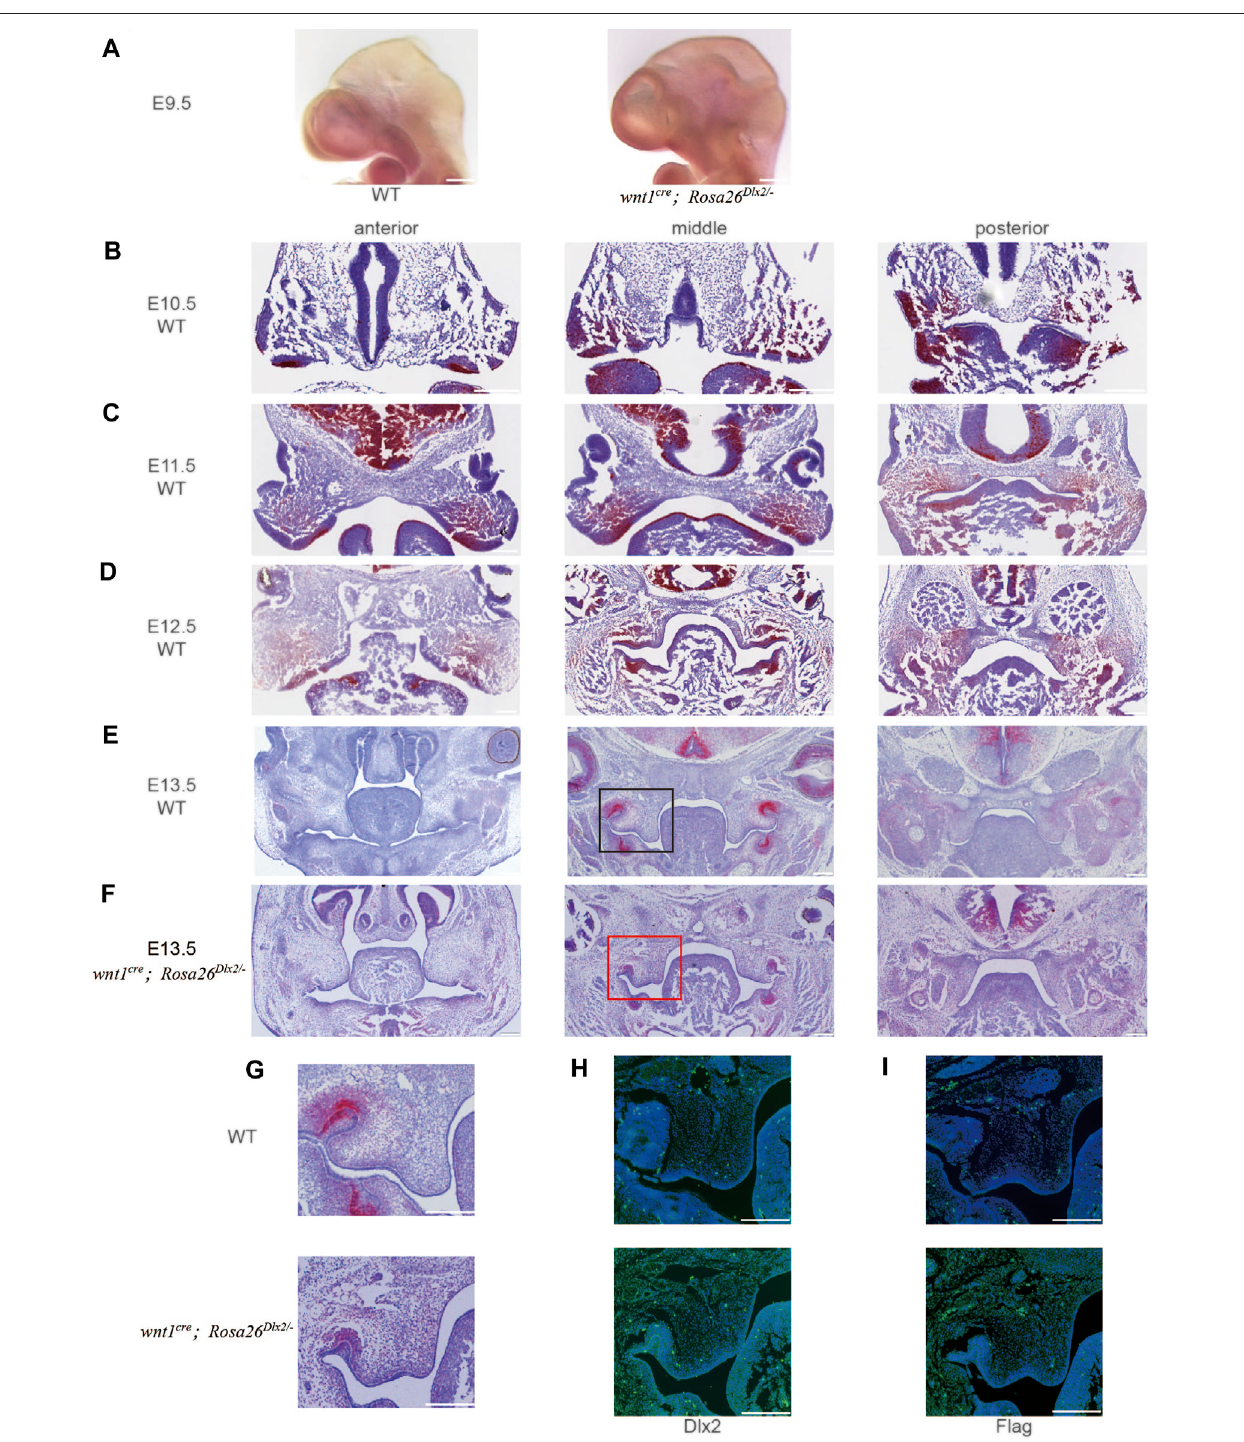
FIGURE2| ThetemporalDlx2expressionpatternduringtheearly-stagedevelopmentofmaxillaryprocessesfromE9.5toE13.5 (A) Thewhole insitu hybridization of E9.5 WT and wnt1 cre ; Rosa26 Dlx2/- mouse head (B-E) In situ hybridization on the head tissue sections of E10.5 (B) , E11.5 (C) , E12.5 (D) , and E13.5 (E) WT embryos and the temporal Dlx2 expression pattern. Note that Dlx2 expression is largely diminished at E13.5 (F) In situ hybridization on the head tissue sections of E13.5 wnt1 cre ; Rosa26 Dlx2/- mouse embryo depicts Dlx2 overexpression in maxillary processes (G) Enlarged picture of the box area in E and F (H) Dlx2 immuno fl uorescence staining ofE13.5WT (up) and wnt1 cre ; Rosa26 Dlx2/- (down) mouse maxillary processes (I) Flag immuno fl uorescence staining of E13.5 WT (up) and wnt1 cre ; Rosa26 Dlx2/- (down) mouse maxillary processes. Bar, 200um.